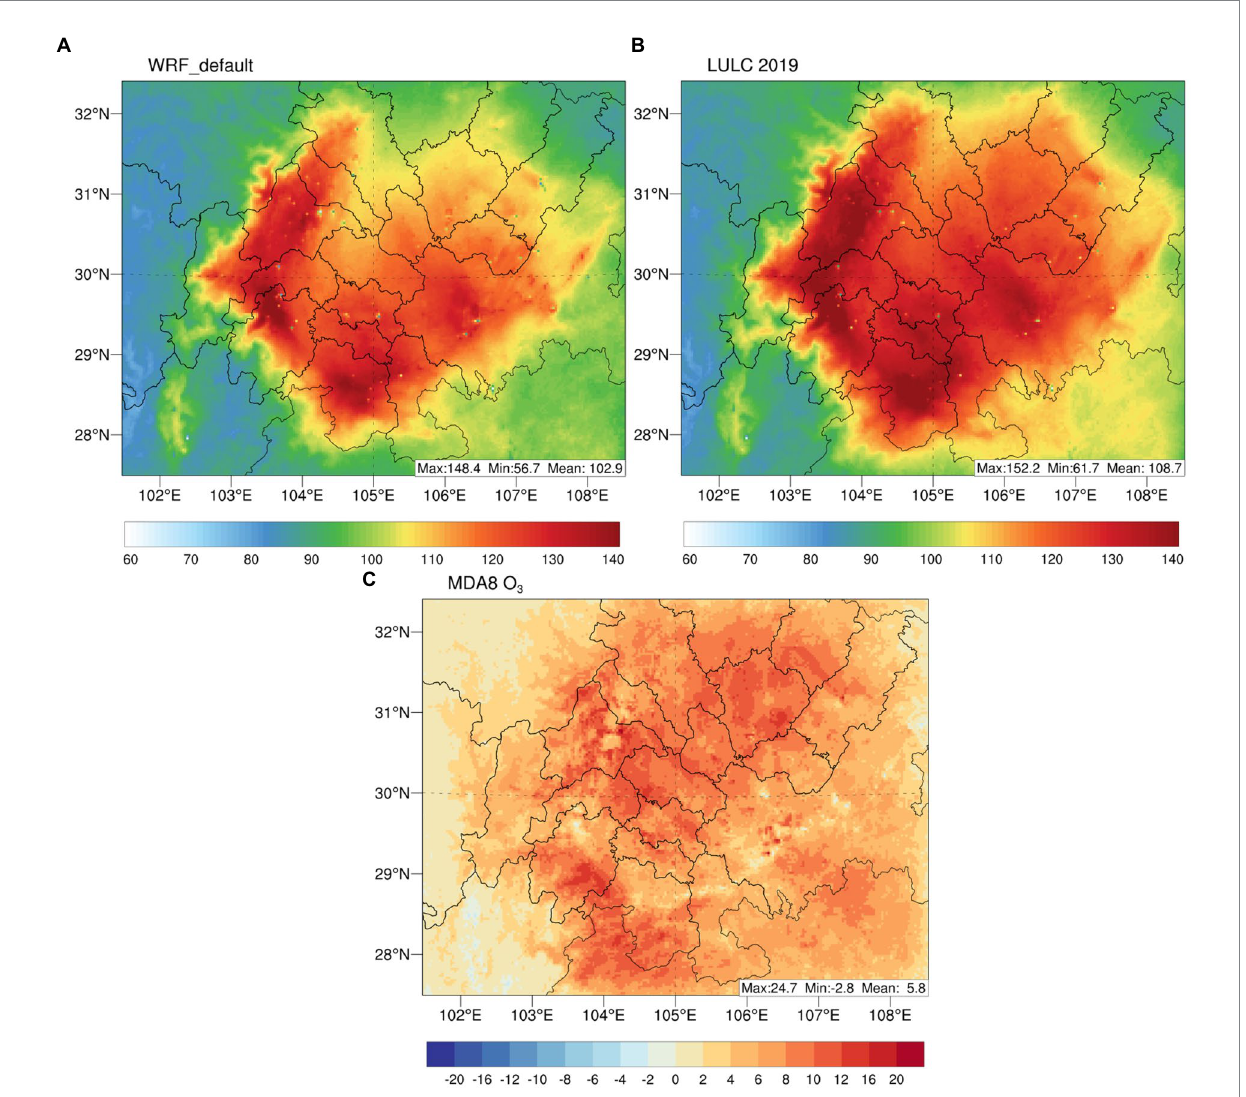
FIGURE 7 Map of simulated monthly-averaged MDA8 O 3 in (A) 2019LULC and (B) WRF_default scenarios and (C) differences of MDA8 O 3 between 2019LULC and WRF_default over the SCB in August 2019.